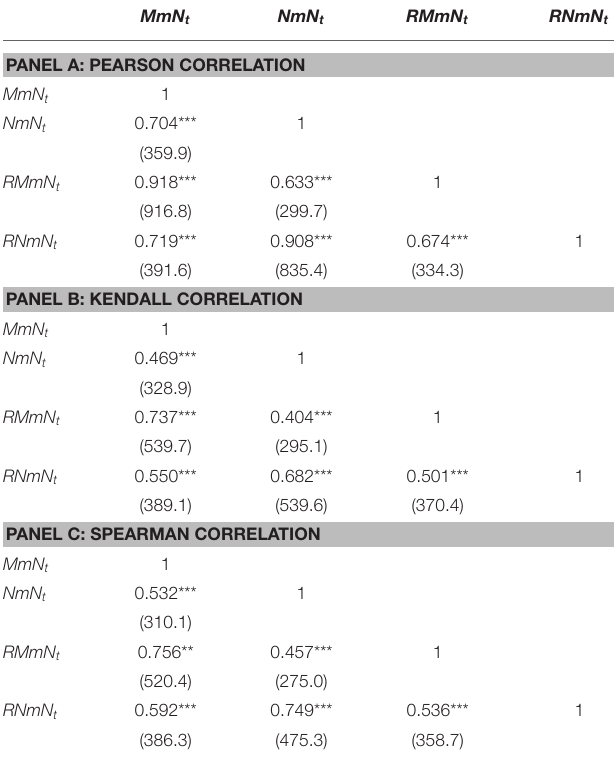
TABLE 7 | The correlation matrix of main-media news.